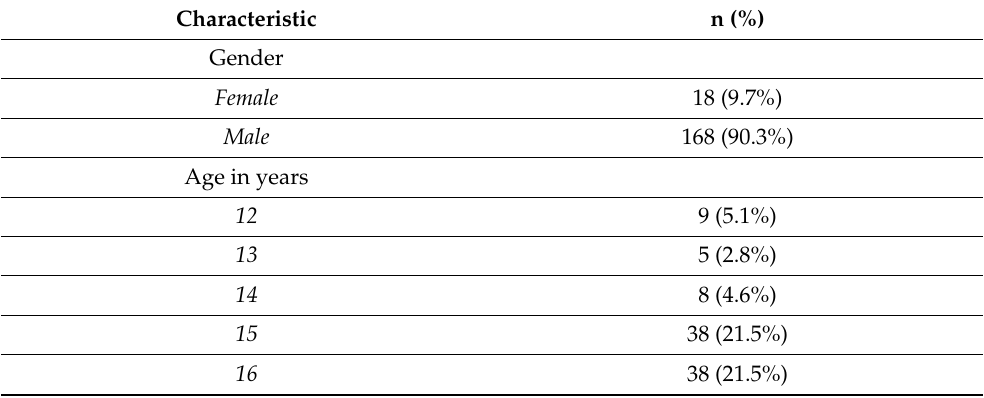
Table 1 details all sociodemographic characteristics. Table 1. Juvenile delinquents’ socio-demographic characteristics (N =